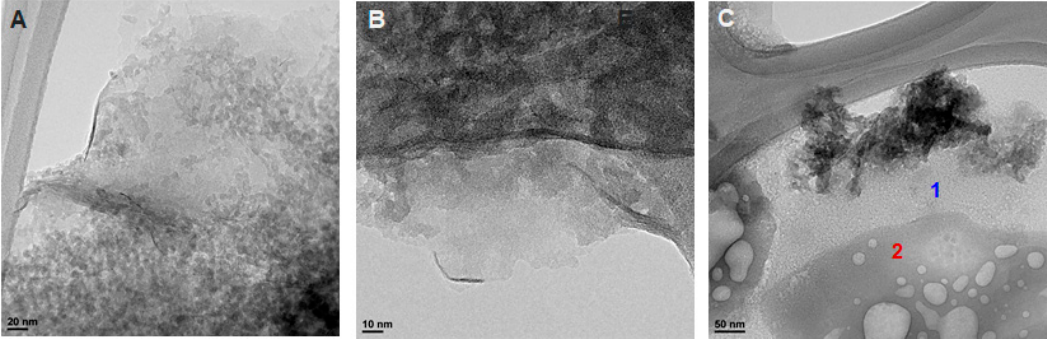
Figure 6. TEM images at different magnification of the Mont/PEDOT-PSS hybrid material.